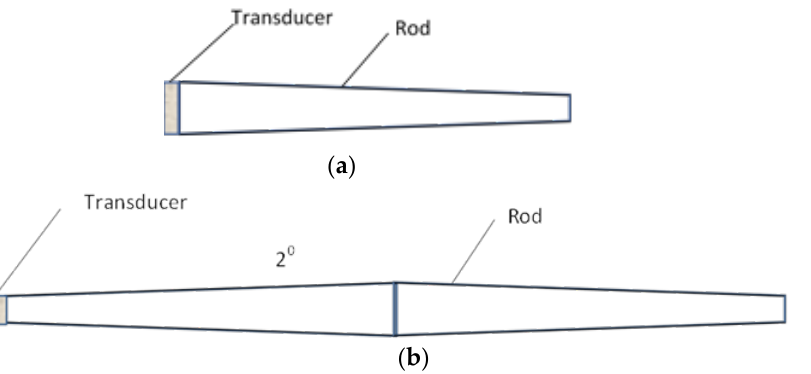
Figure 3. Buffer rods with circular cross-section for reducing trailing waves; ( a ) tapered rod; ( b ) double tapered.